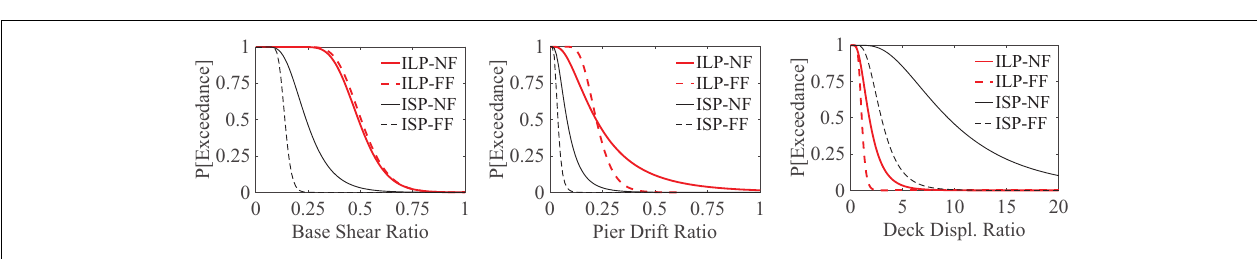
FIGURE 11 | Probability of exceeding the ratio of the maximum resultant responses of the isolated models from a given value.